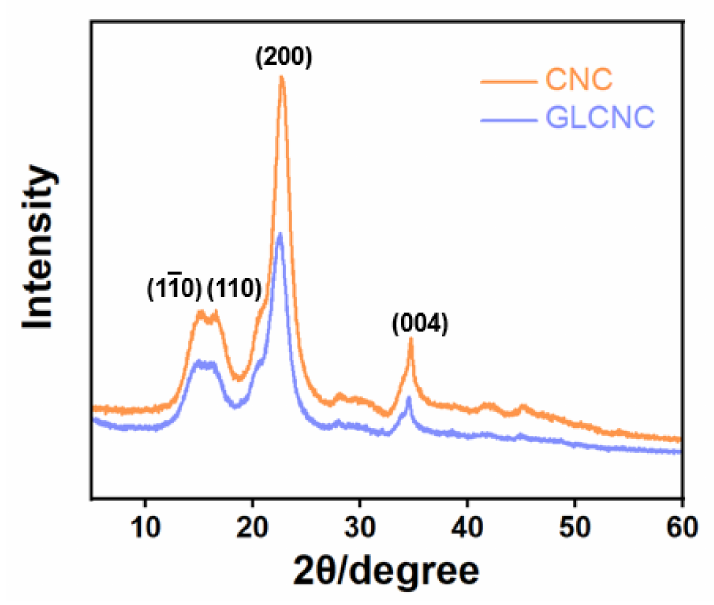
Figure 3. XRD patterns of CNCs and